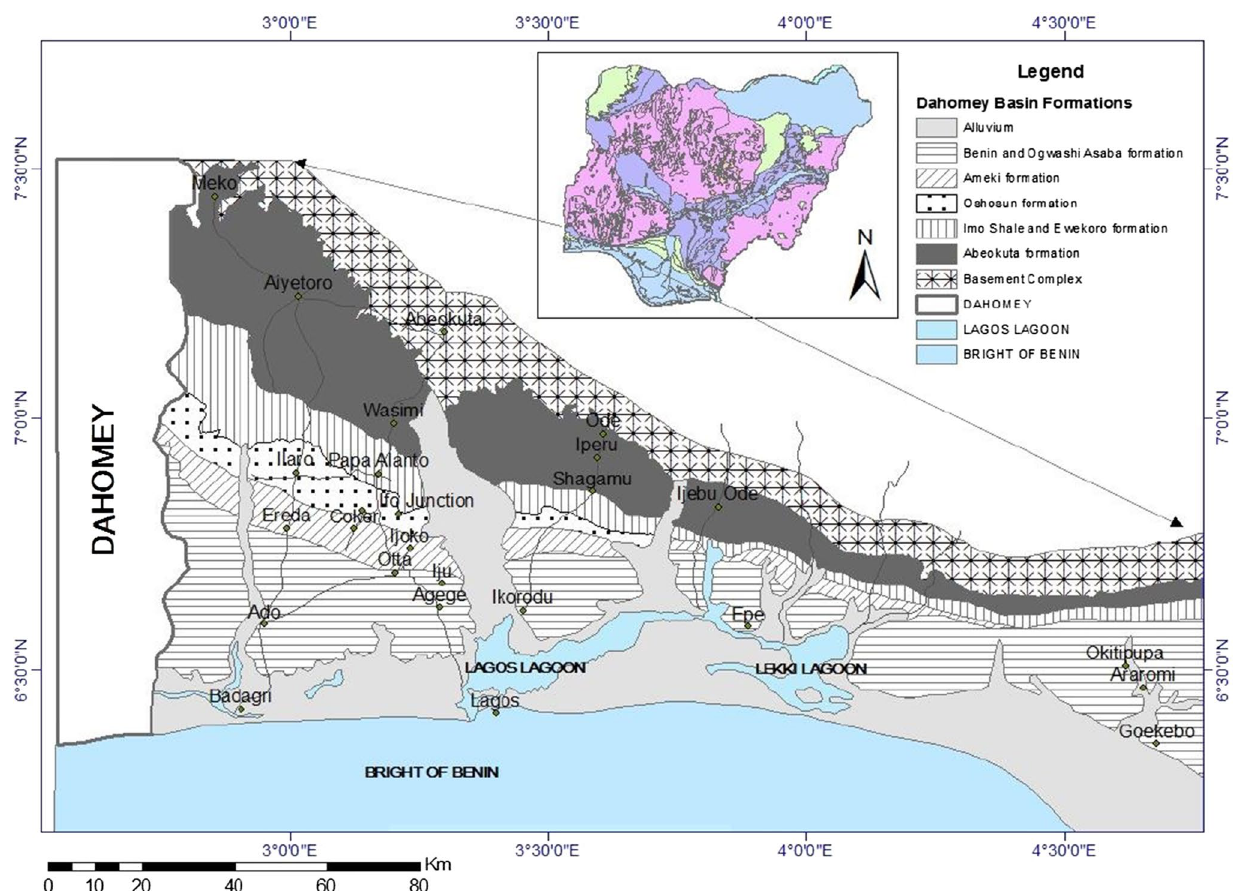
Fig. 1 Geological map of Lagos State, inset map of Nigeria (after NGSA